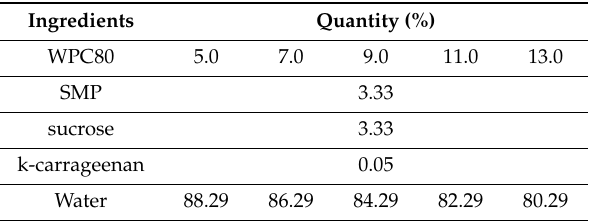
Table 1. Composition of high-protein fat-free dairy